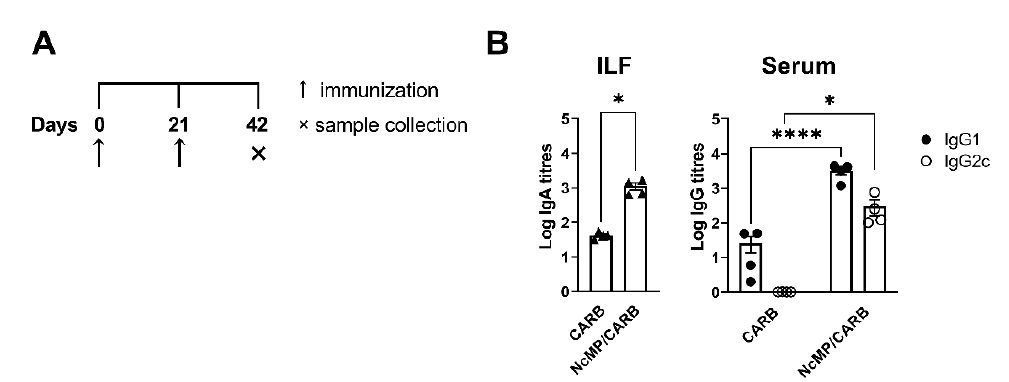
Figure 3. Analysis of N. caninum -specific antibodies. Timeline of immunization and sample collection ( A ). Titers of intestinal lavage fluid (ILF) IgA and serum (Serum) IgG1 and IgG2c ( B ), as indicated, were determined by ELISA in samples collected, on the indicated day, from mice of CARB and NcMP/CARB groups. Data is presented as log 10 of the antibody titers ( n = 4 per group). Each symbol (triangles and circles) represents an individual mouse. Bars correspond to the mean value